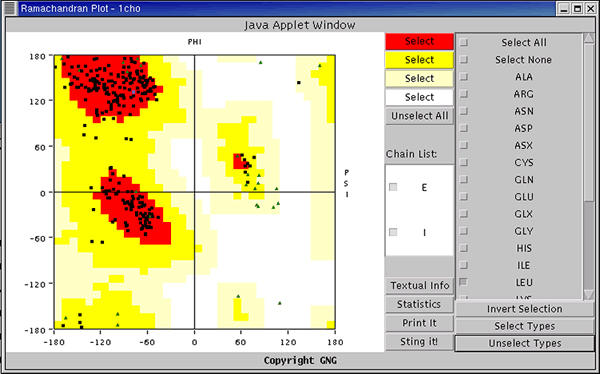
SMS Ramachandran interactive plot. Ramachandran plot of 1cho.pdb, highlighting the position of Leu_46 (blue colored spot), chain E in the diagram, and coloring plotted areas according to the allowed regions for the phi and psi angles. This image shows also the area of the applet which is dedicated to sub setting of the amino acids according to their type and position in the allowed and disallowed areas.